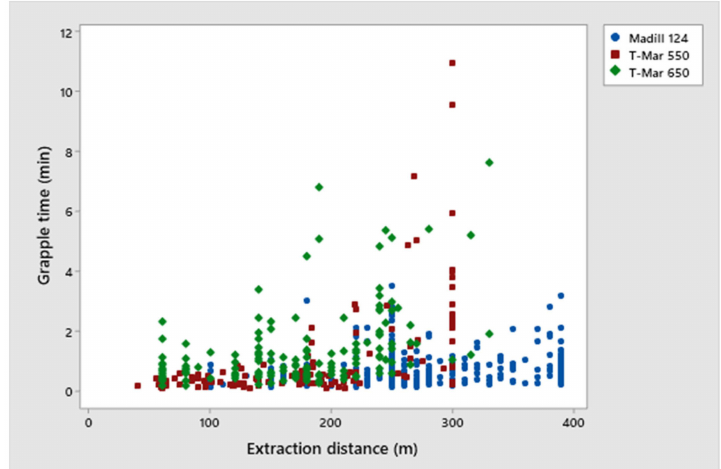
Figure 3. Relationship between grapple time and extraction